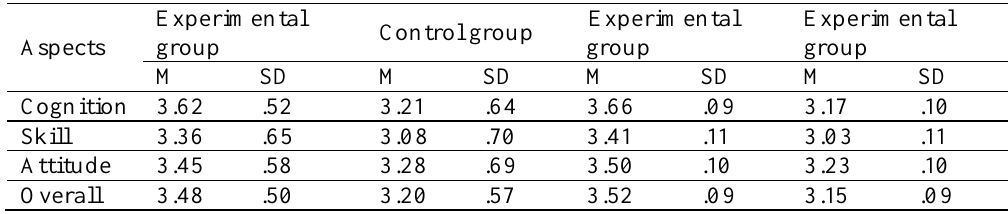
Table 11 Descriptive Statistics for Self-Assessment of Both Groups